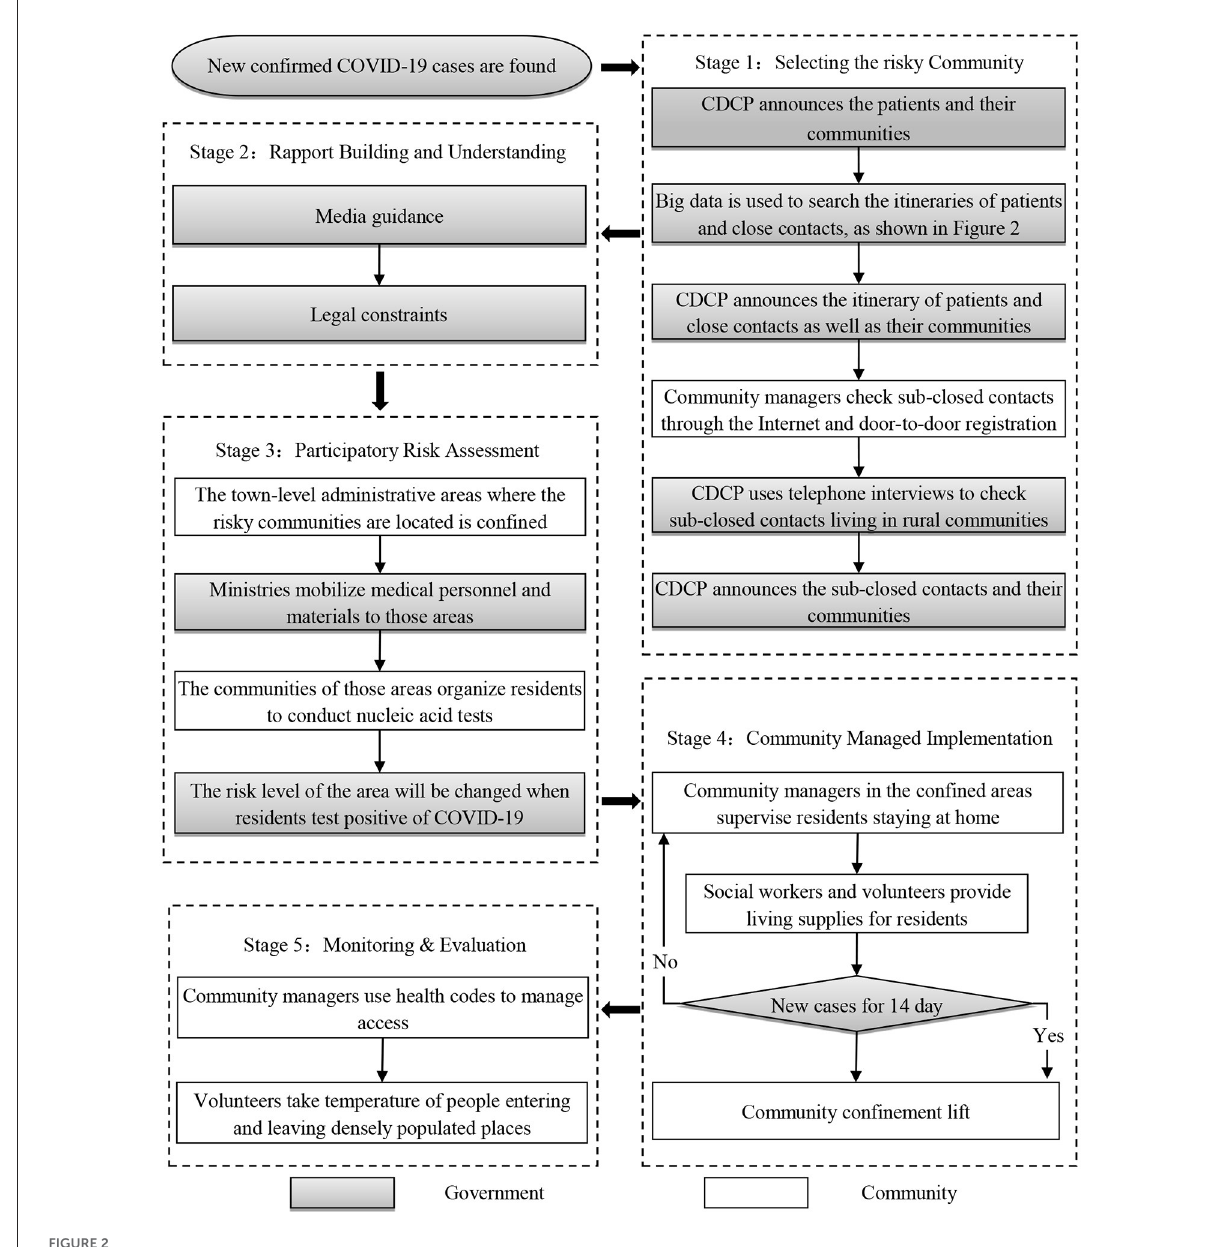
FIGURE2 Steps of China’s CBCM